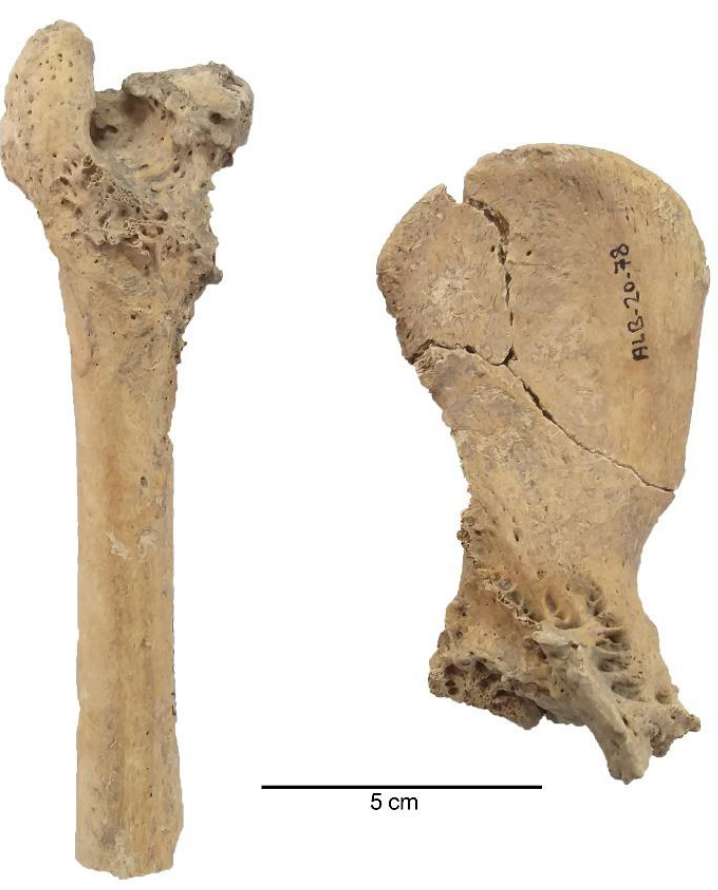
Figure 8. Example of coxal dysplasia and osteophyte proliferations in the Alaybeyi dog bones—these two specimens apparently belonged to a single individual: ( left ) femur; ( right ) os coxae.